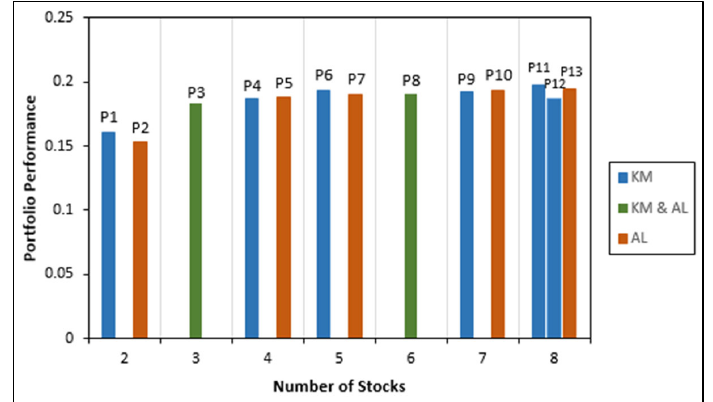
Fig. 4. Portfolio Performance Grouped by Number of